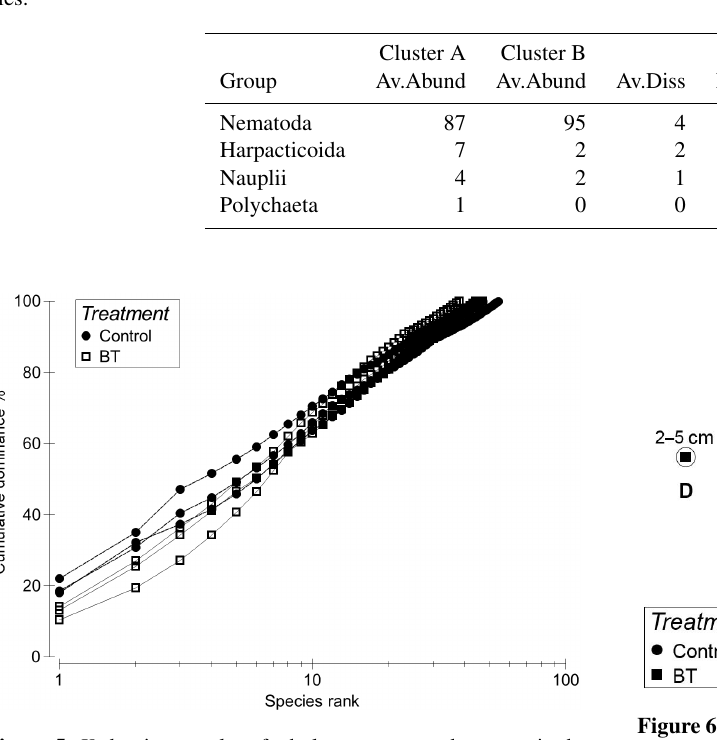
Figure 5. K -dominance plot of whole core nematode genera in the Burial treatment (BT) and the Control.